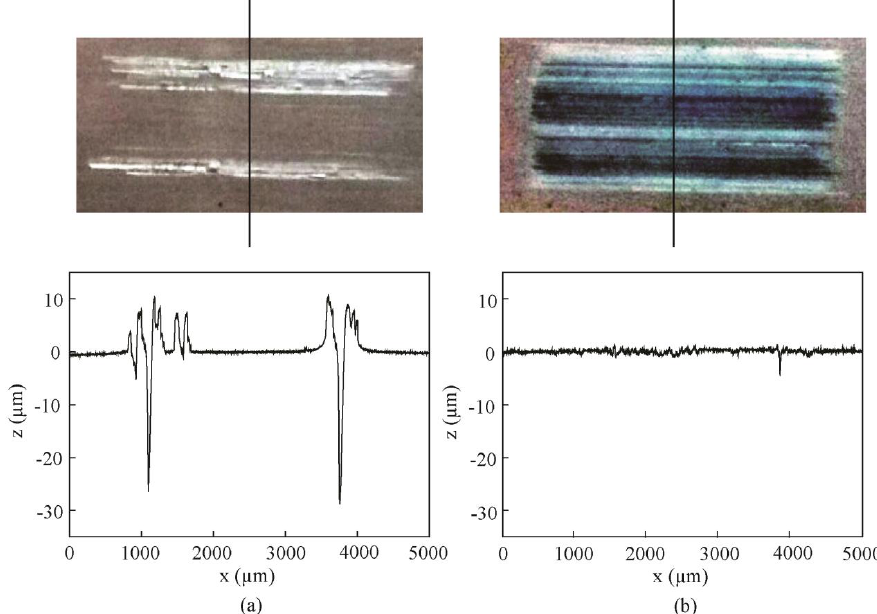
Figure 14. Wear scar images and 2D profile curves of samples lubricated with ( a ) base oil and ( b ) base oil with 0.5 wt % MoO 3 at 150 °C.